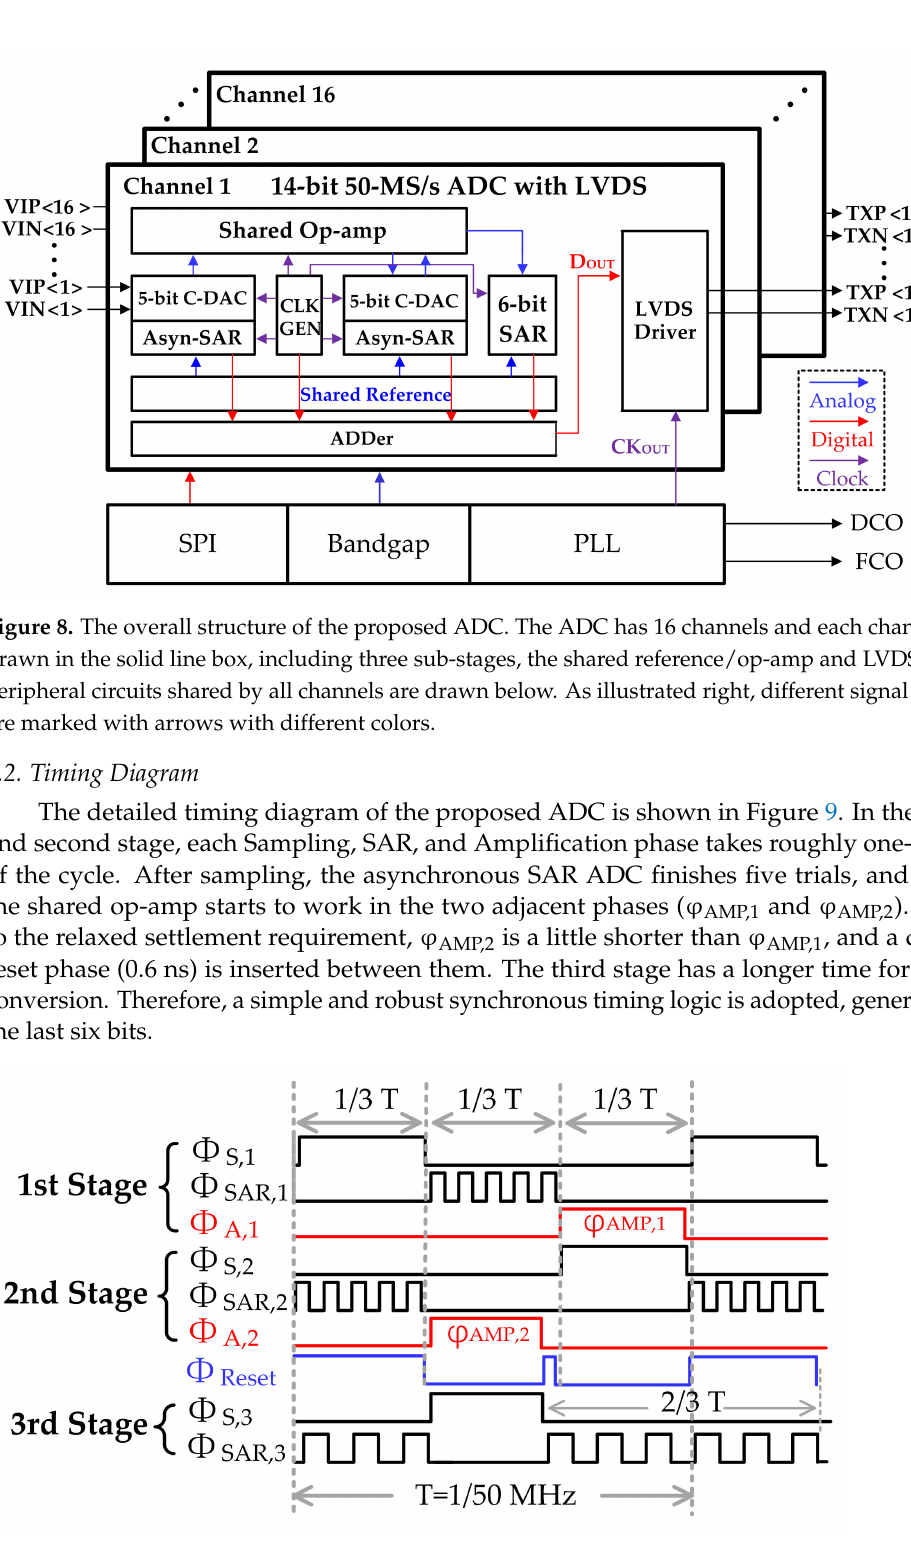
Figure 9. The timing diagram of the proposed ADC. The detailed phase clock of each stage is grouped. The shared op-amp has two operating phases (red line), and the Reset phase (blue line) is inserted between them. The Sampling, SAR, and Amplification phases each take one-third of the